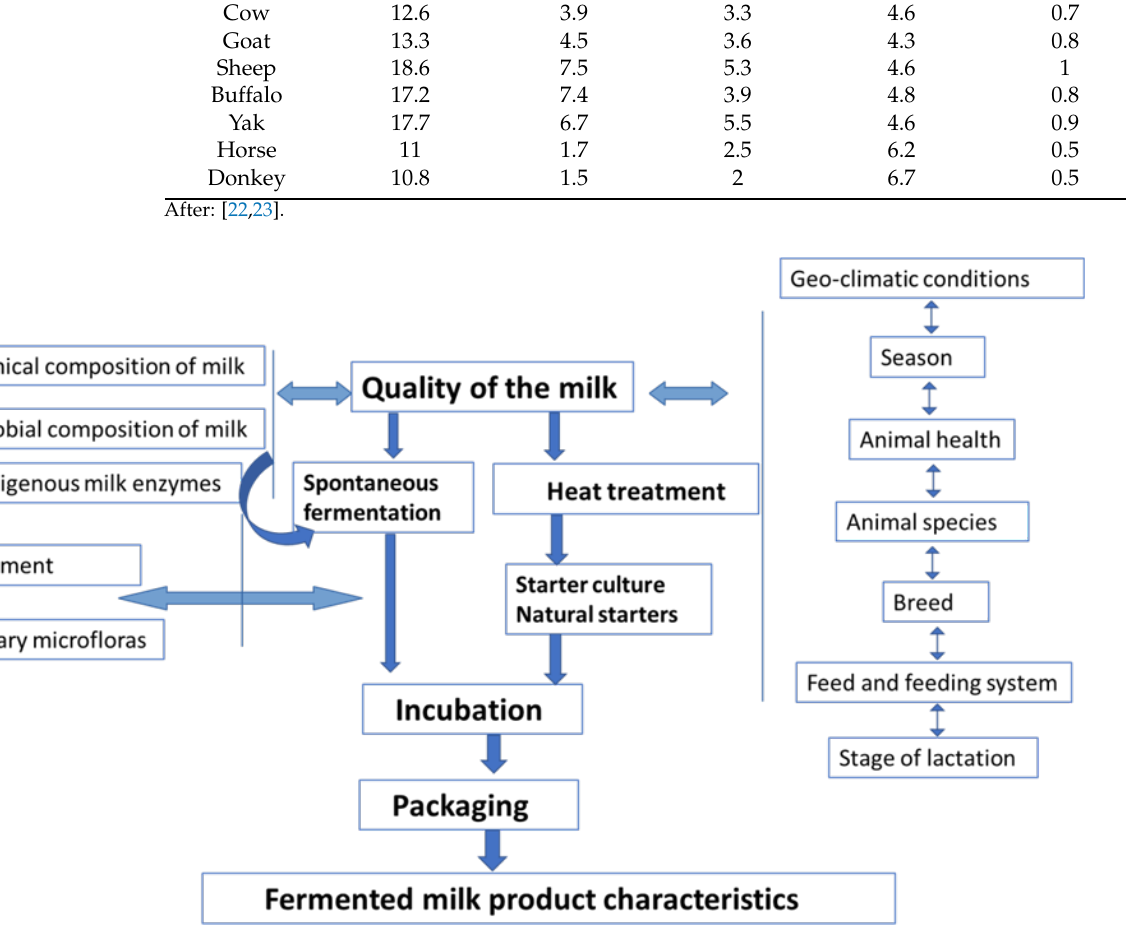
Figure 1. Main factors affecting the characteristics of fermented milk products.